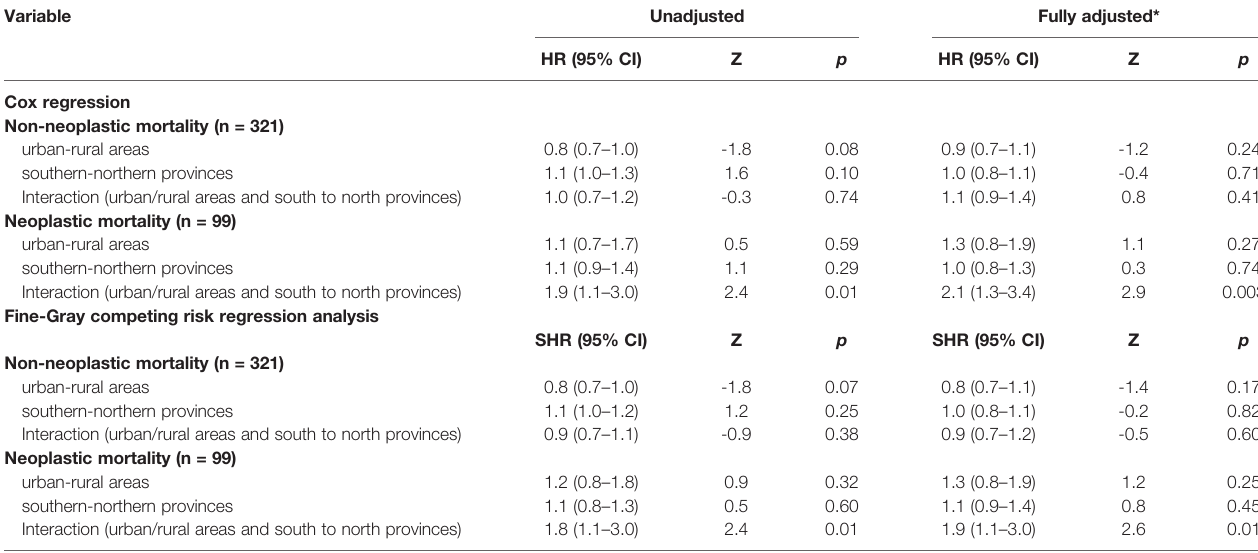
TABLE 2 | Cox regression and Fine-Gray competing risk regression analysis of non-neoplastic and neoplastic mortality risk over 22 years of follow-up after ACS with the interaction for risks between the six geographic areas (n = 541). Variable Unadjusted Fully adjusted* HR (95% CI) Z p HR (95% CI)